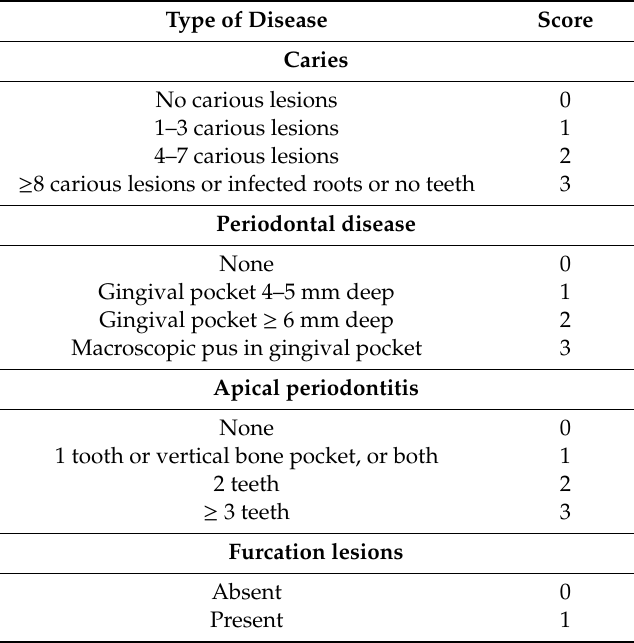
Table 1. Details and definition of the modified total dental index (TDI) used in this study